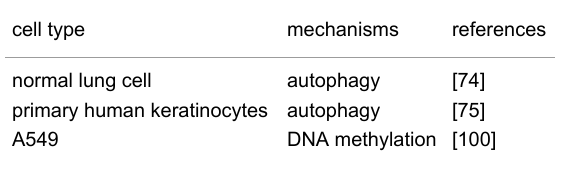
Table 3: Autophagy and DNA methylation in non-neuronal cells in- duced by TiO 2 NPs. cell